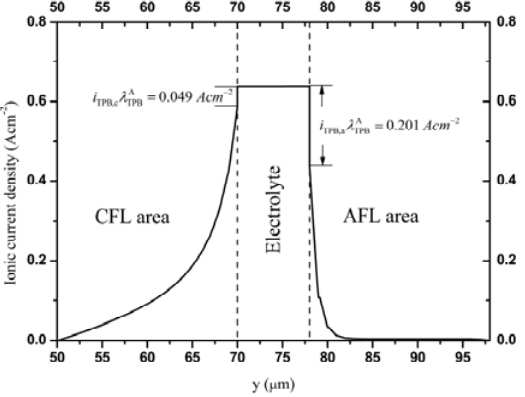
Figure 4. The ionic current density distribution in the CFL, electrolyte and AFL at x =